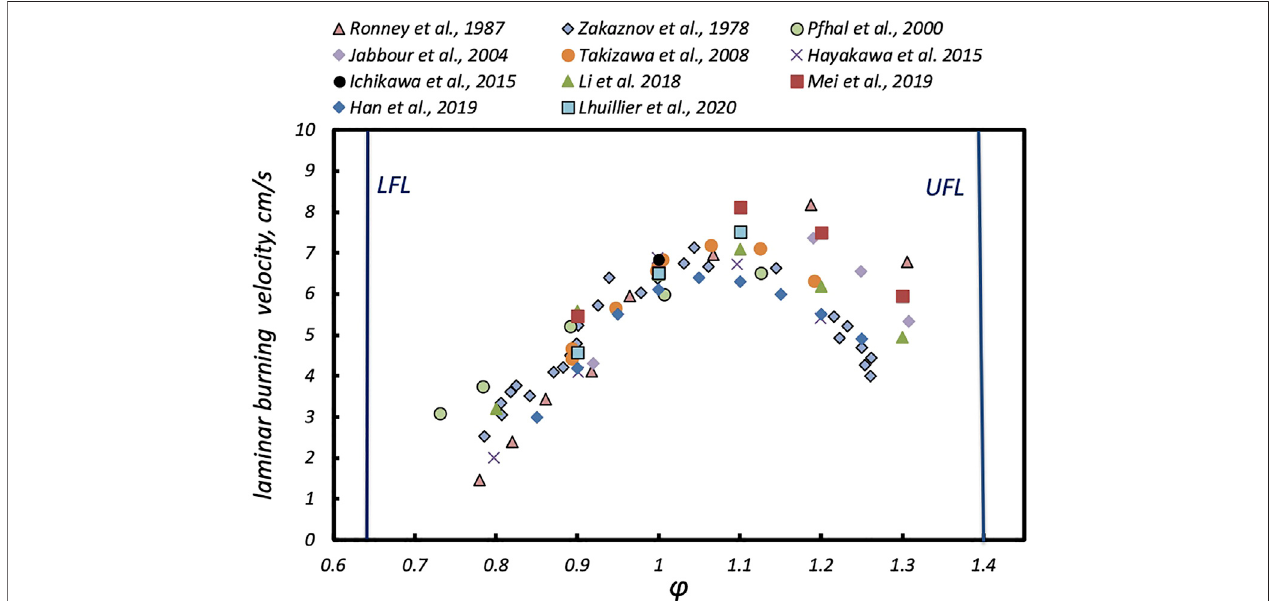
FIGURE 4 | S L as a function of the fuel “ enhancer ” addition (reported as %) or of the O 2 content.